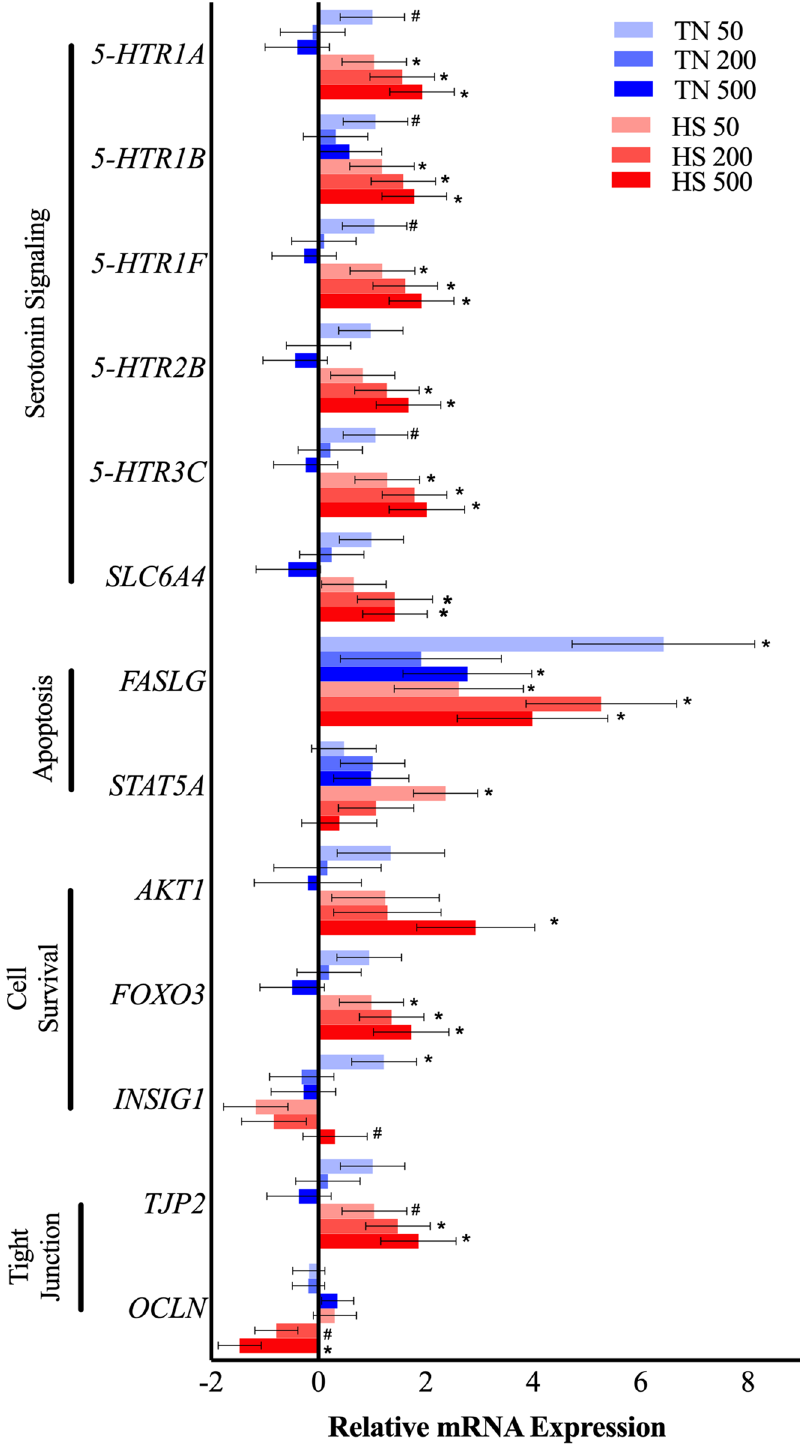
Figure 5. Interaction between 5-Hydroxy-L-tryptophan (5-HTP) dose and incubation temperature. Gene expression of primary bovine mammary epithelial cells (pBMEC) after 12-h exposure of either 0, 50, 200 or 500 μM dose of 5-HTP under thermoneutral (37 °C, TN) or heat shock (41.5 °C, HS) culture conditions. Data is presented as relative mRNA expression (∆∆Ct = ∆Ct TN Dose 0 (CON) − ∆Ct treatment)) ± standard error of the mean (SEM). Significance declared at P value ≤ 0.05 (*) and (#) denotes a statistical tendency at 0.05 < P value ≤